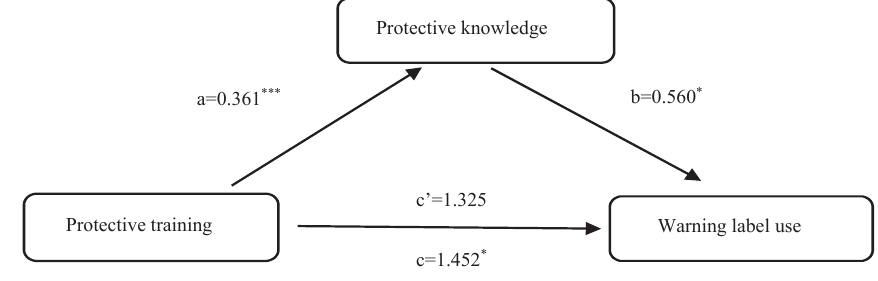
Table 2. Association between protective training regarding AD exposure, protective knowledge, and use of warning